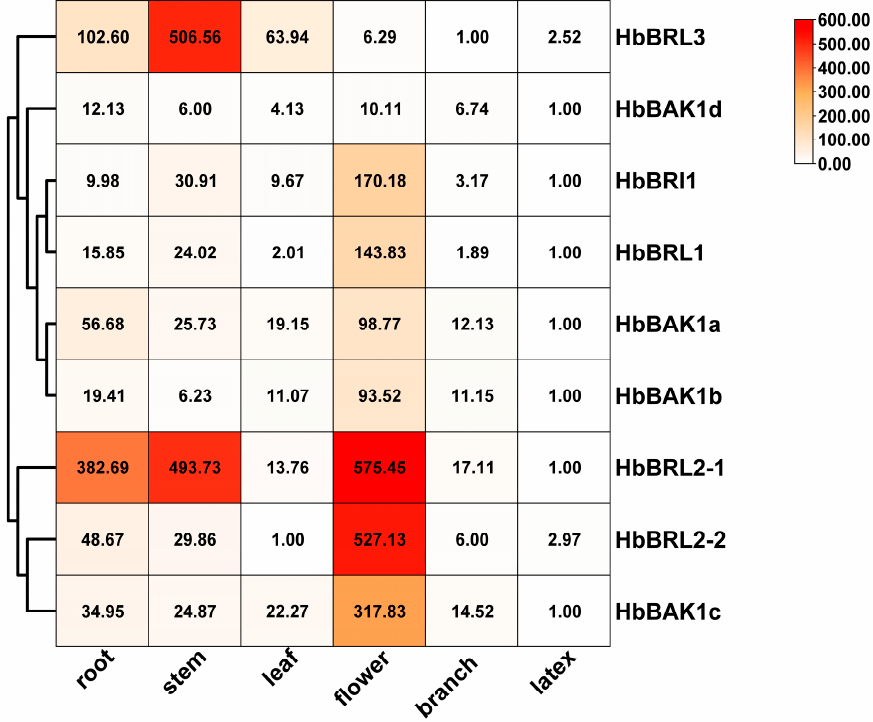
Figure 6. Expression patterns of HbBRI1 and HbBAK1 genes in different tissues. HbActin was the reference gene. The tissue with the lowest expression of each gene was the control, set as 1. Values in the box represent relative expression level. Expression values are shown in different colored boxes. White and red represent low and high expression levels, respectively.